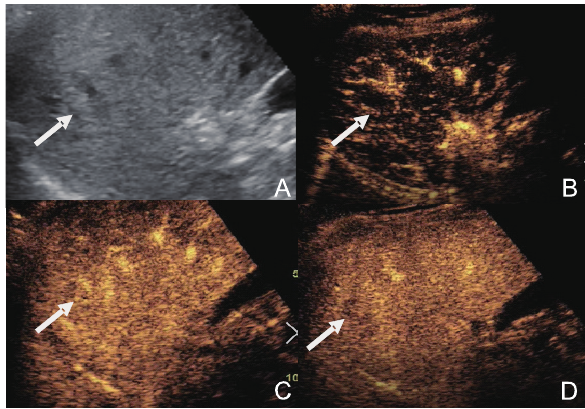
Figure 1 (A) Abdominal ultrasound show a nodule in posterior segment of right lobe, 8 ×7 mm. (B) Peripheral enhancement in the arterial phase of contrast-enhanced ultrasound. (C) Low contrast enhancement in portal venous phase of contrast-enhanced ultrasound. (D) Low contrast enhancement in delay phase of contrast-enhanced